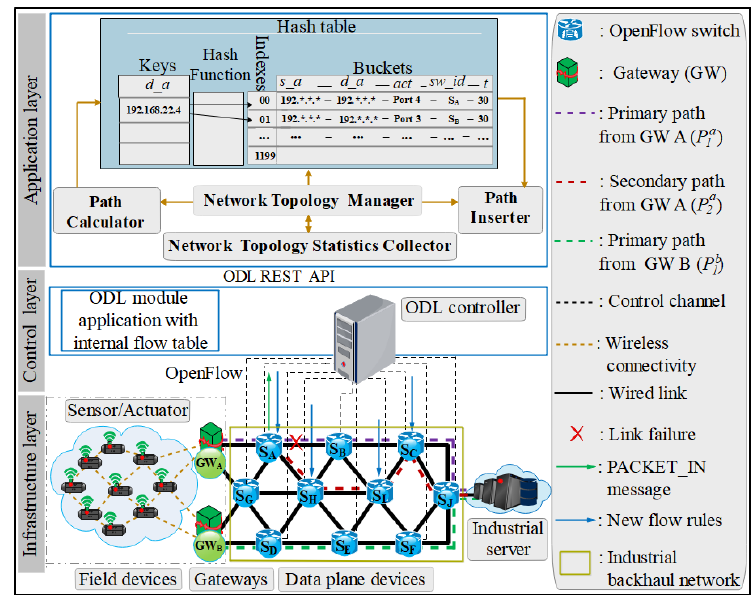
Figure 5. Network topology with a link failure scenario.